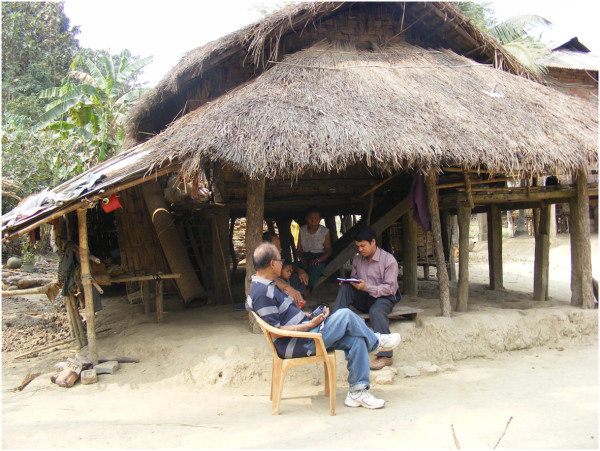
Interviews with a tribal family in Bandarban.